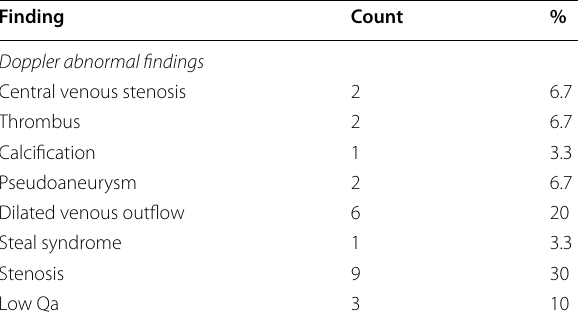
Table 3 The abnormal findings in AVFs CDU examination